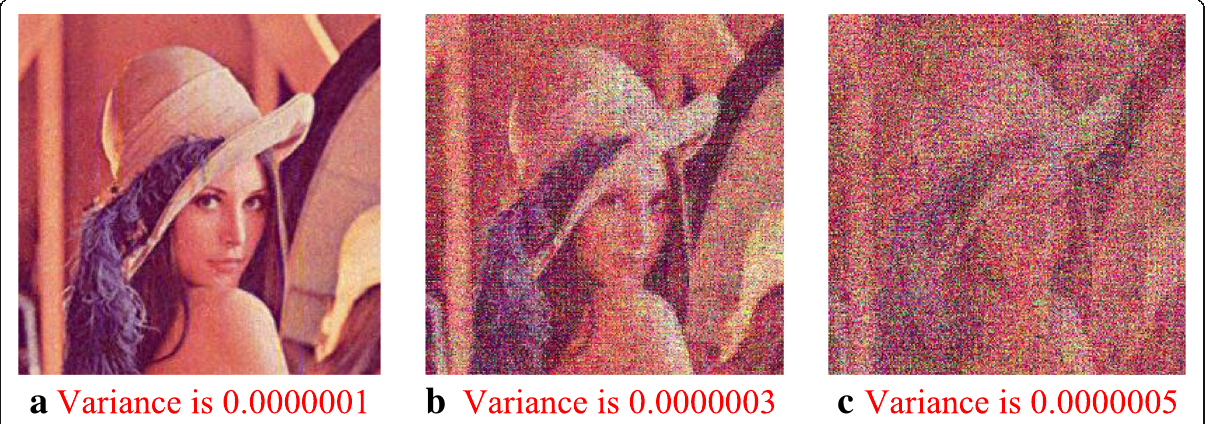
Fig. 7 Noise attack analysis. a Variance is 0.0000001; b variance is 0.0000003; c variance is 0.0000005